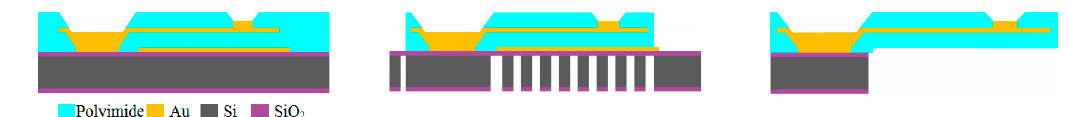
Figure 1. General fabrication steps of flexible gold electrode array: deposition and structuring of gold and polyimide layer by layer ( left ); deep reactive ion etching of silicon ( middle ) and releasing of the array by chemical etching of gold sacrificial layer ( right ).